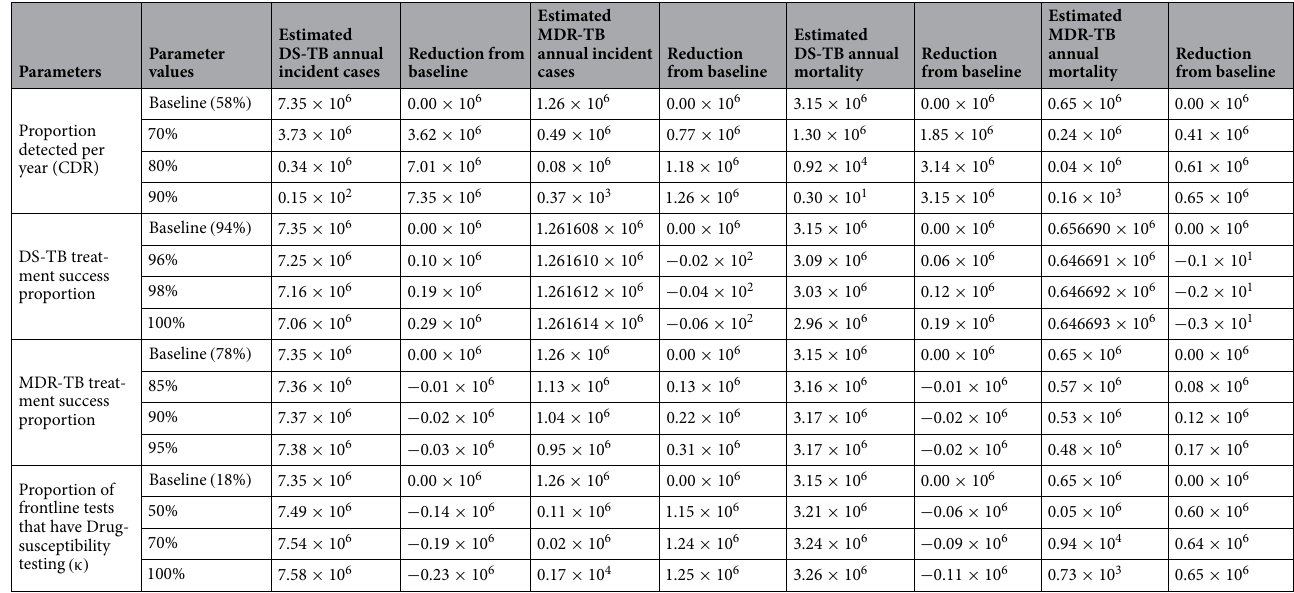
Table 3. Hypothetical single intervention strategy implemented in our proposed model of DS and MDR-TB control in Bangladesh, for the period